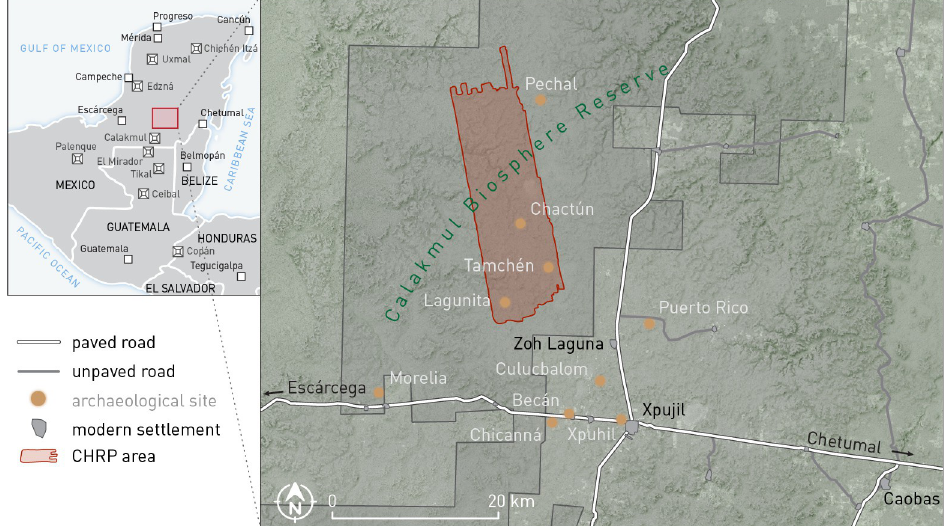
Fig 1. Location of the CHRP area and major archaeological sites in eastern Campeche,